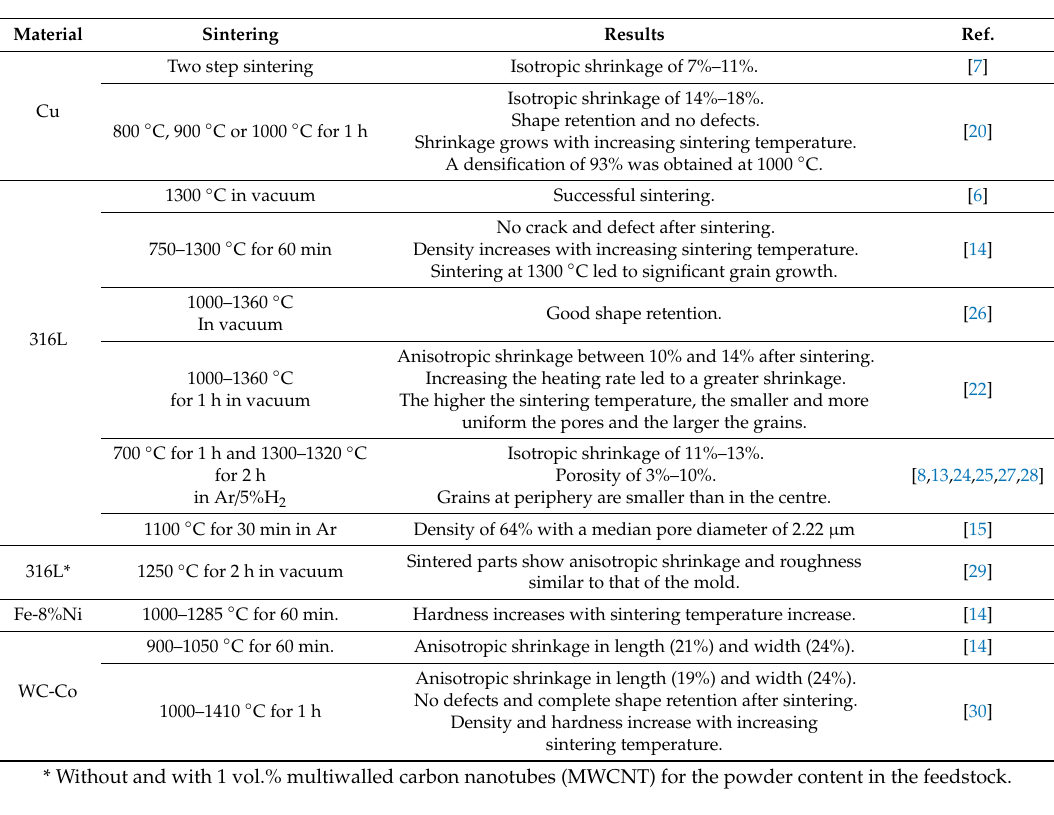
Table 6. Achievements related to sintered parts by the powder hot embossing process.